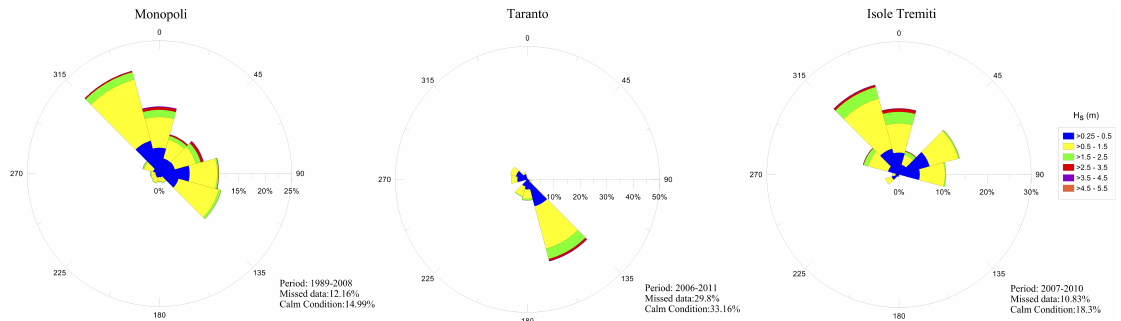
Figure 2. Wave roses estimated from the wave timeseries collected offshore Tremiti Islands, Monopoli and